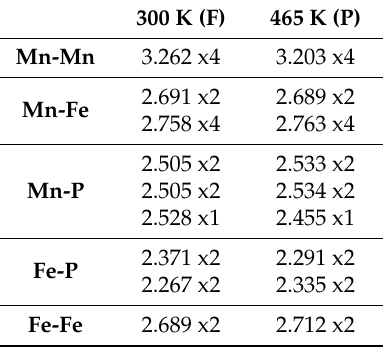
Table A2. A comparison of interatomic distances for MnFeP 0.5 Si 0.at temperatures apart T C